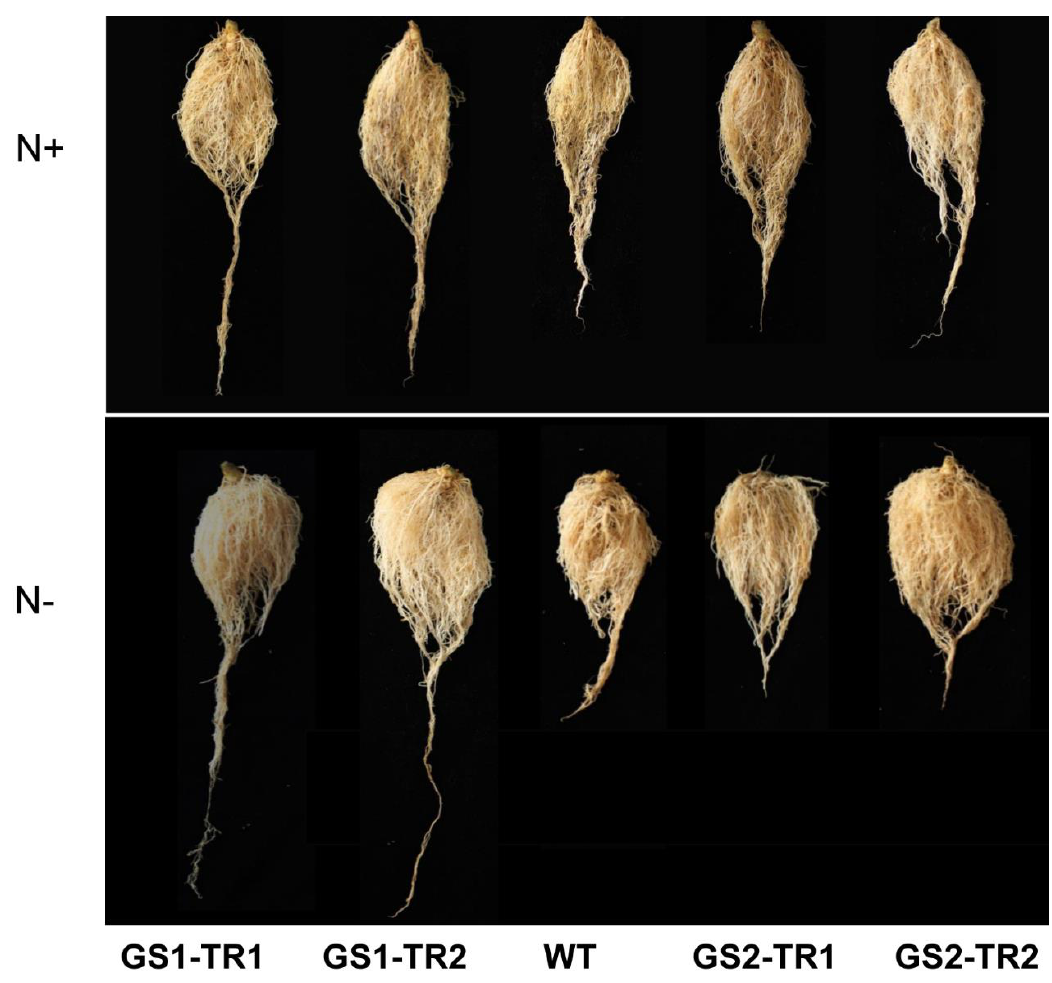
Figure 8. The root phenotype of transgenic tobacco GS1-TR and GS2-TR, compared with that of the WT, after 7 weeks of growth under nitrogen-sufficient (N+) and nitrogen-starvation (N − ) conditions.